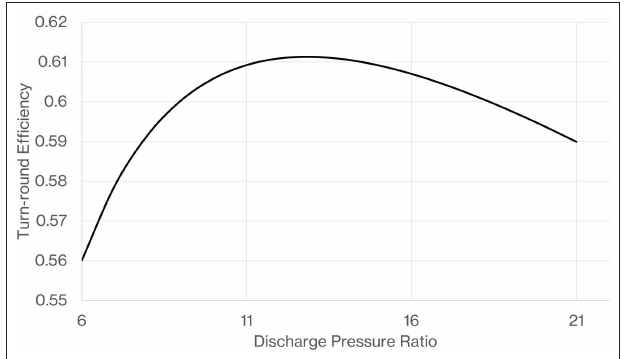
FIGURE 22 | Advantage of reducing discharge pressure ratio, charging pressure ratio constant at 20.